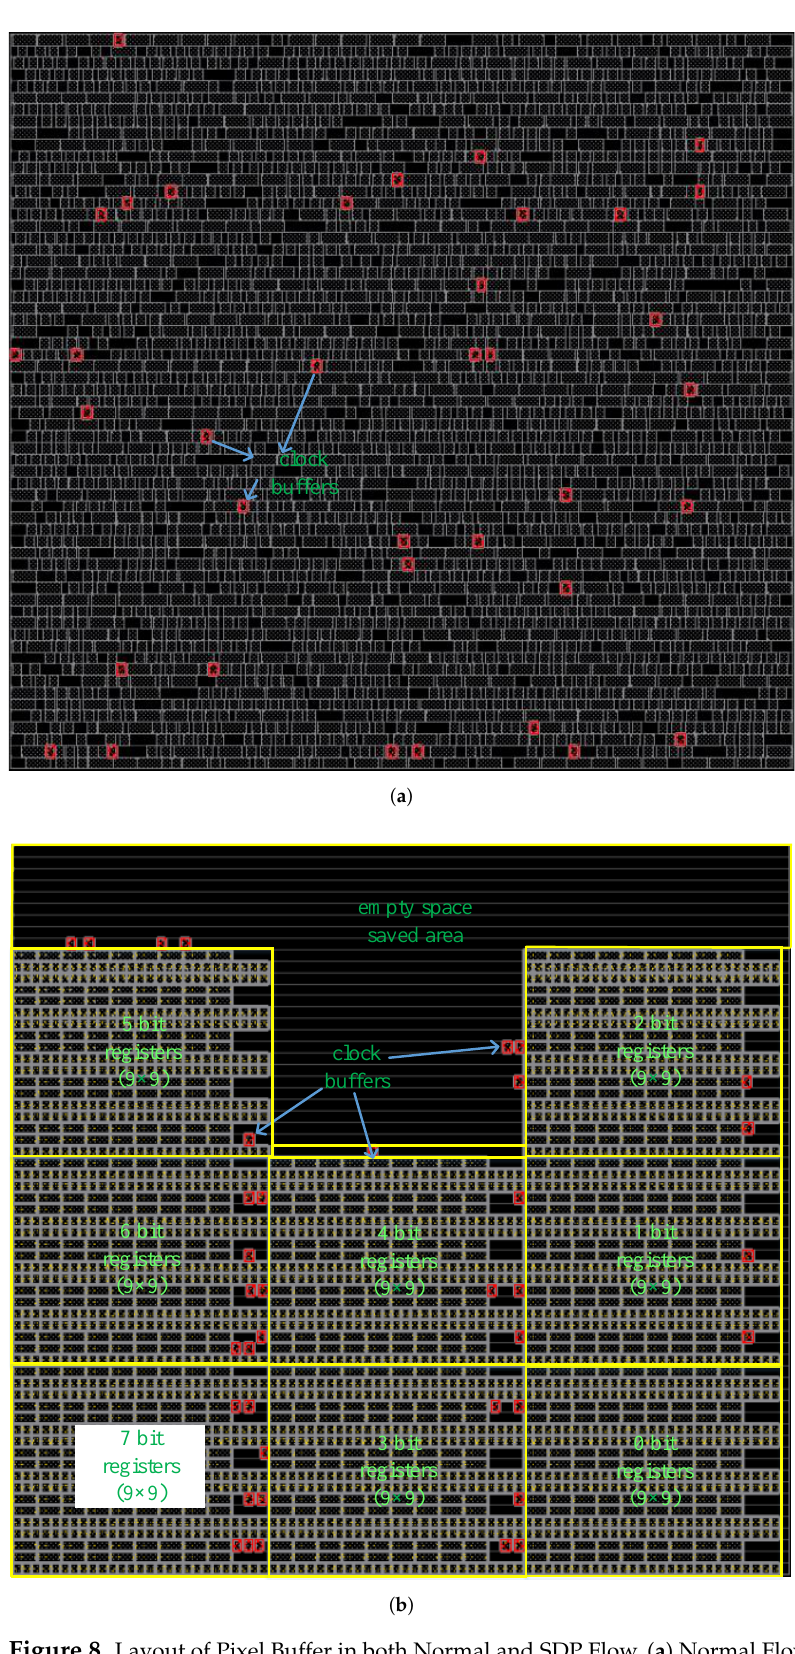
Figure 8. Layout of Pixel Buffer in both Normal and SDP Flow. ( a ) Normal Flow. ( b ) SDP